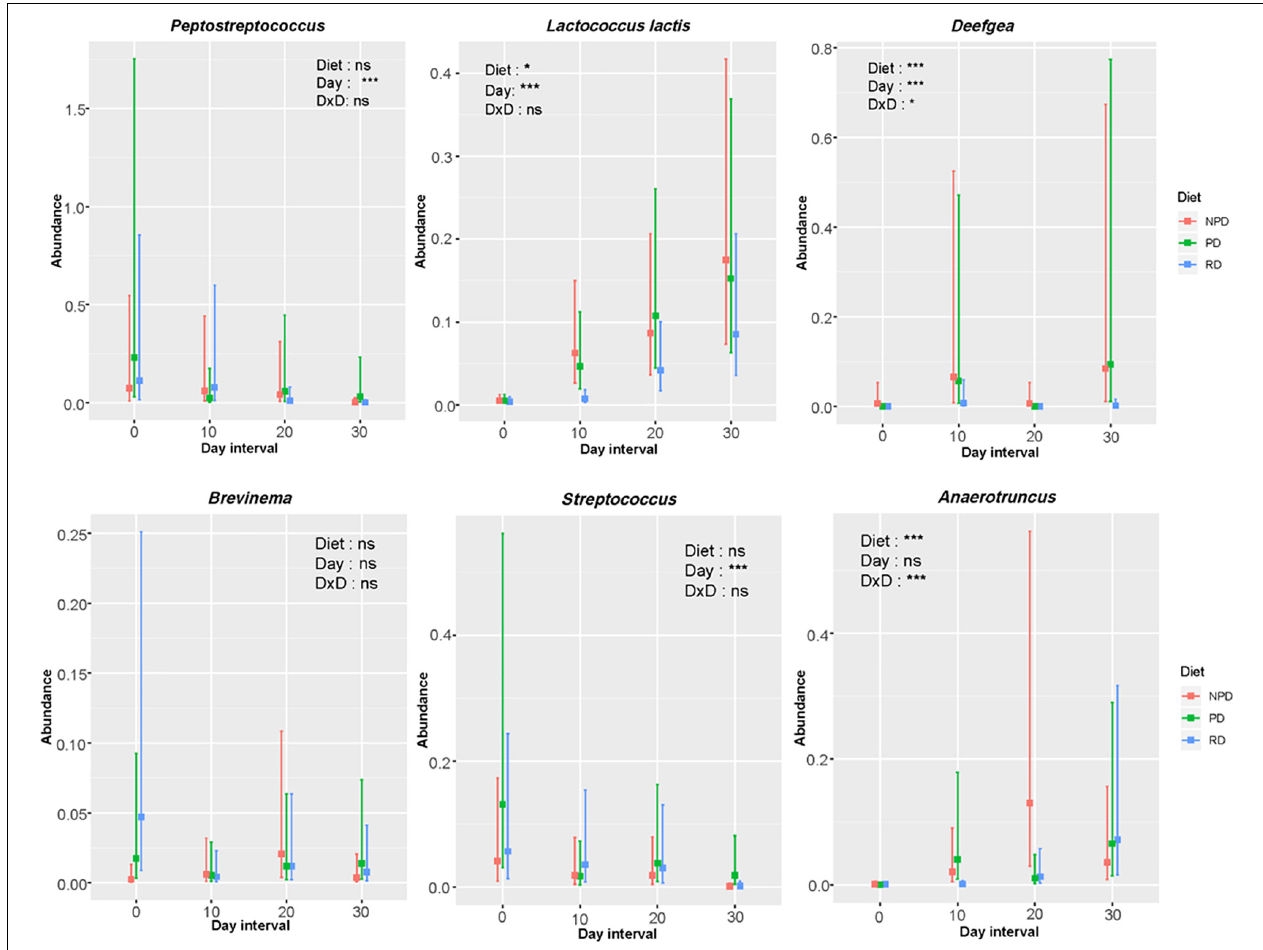
FIGURE 5 | Interaction plot showing relative abundance of the top six bacterial taxa in the gut bacterial community of rainbow trout. RD: reference diet, PD: preconditioned (heat-processed) diet, NPD: non-preconditioned diet. Until day 0, all fish had been fed a commercial diet. The vertical bar in the plot represents confidence interval and overlapping bars means the difference is not significant. Significance: *** p < 0.001, ** p < 0.01, * p < 0.05, and ns p >